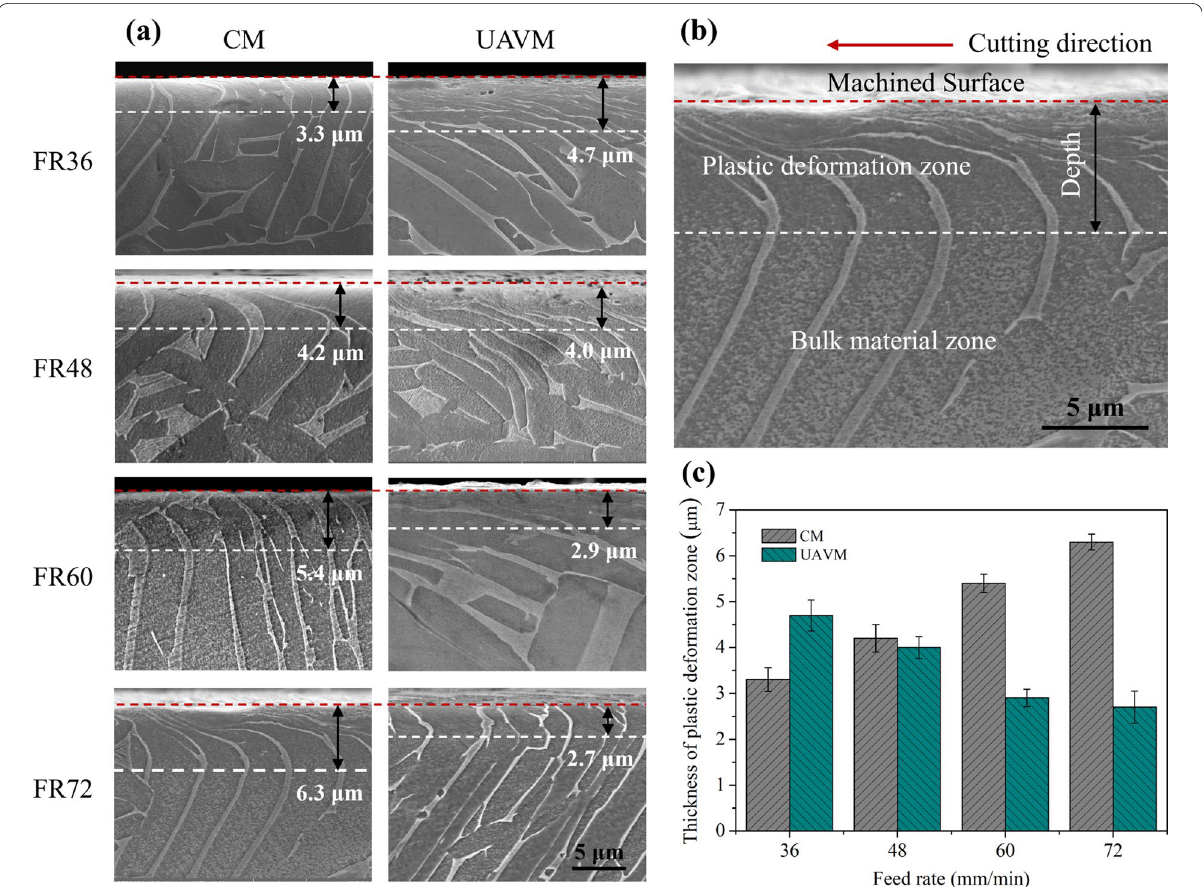
Figure 8 Subsurface microstructure alteration: a machined subsurface microstructures of the workpieces under different machining conditions, b a typical subsurface layer of a workpiece after machining, c variation of depth of the plastic deformation zones measured from a under different machining conditions (FR means feed rate)